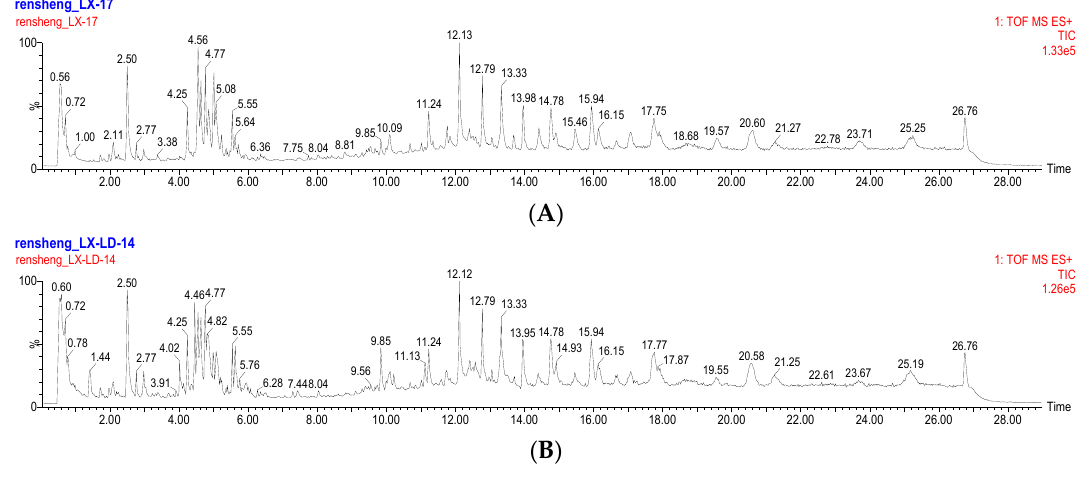
Figure 1. Representative based peak intensity (BPI) chromatograms of LX-P and LX-L samples. ( A ) Natural air dried ginseng (LX-P); ( B ) Vacuum freeze-dried ginseng (LX-L). Table 1. Characterization of ginsenosides in LX-L and LX-L using UPLC-QTOF-MS/MS.